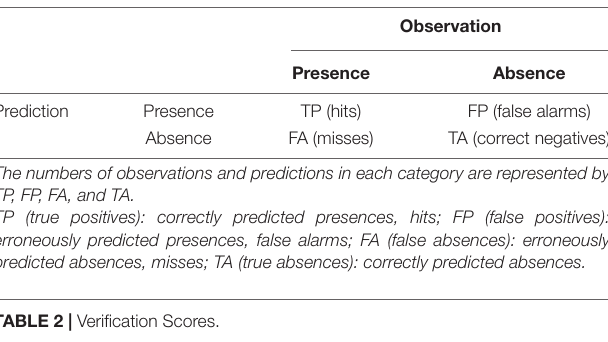
TABLE 1 | Contingency table used to evaluate the predictive accuracy of binary events.